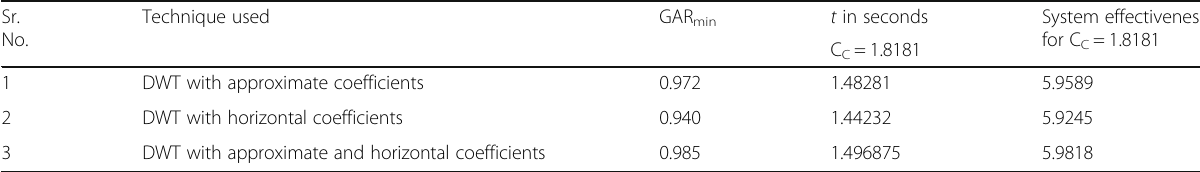
Table 8 Summary of results for C C = 1.8181 Sr. No.